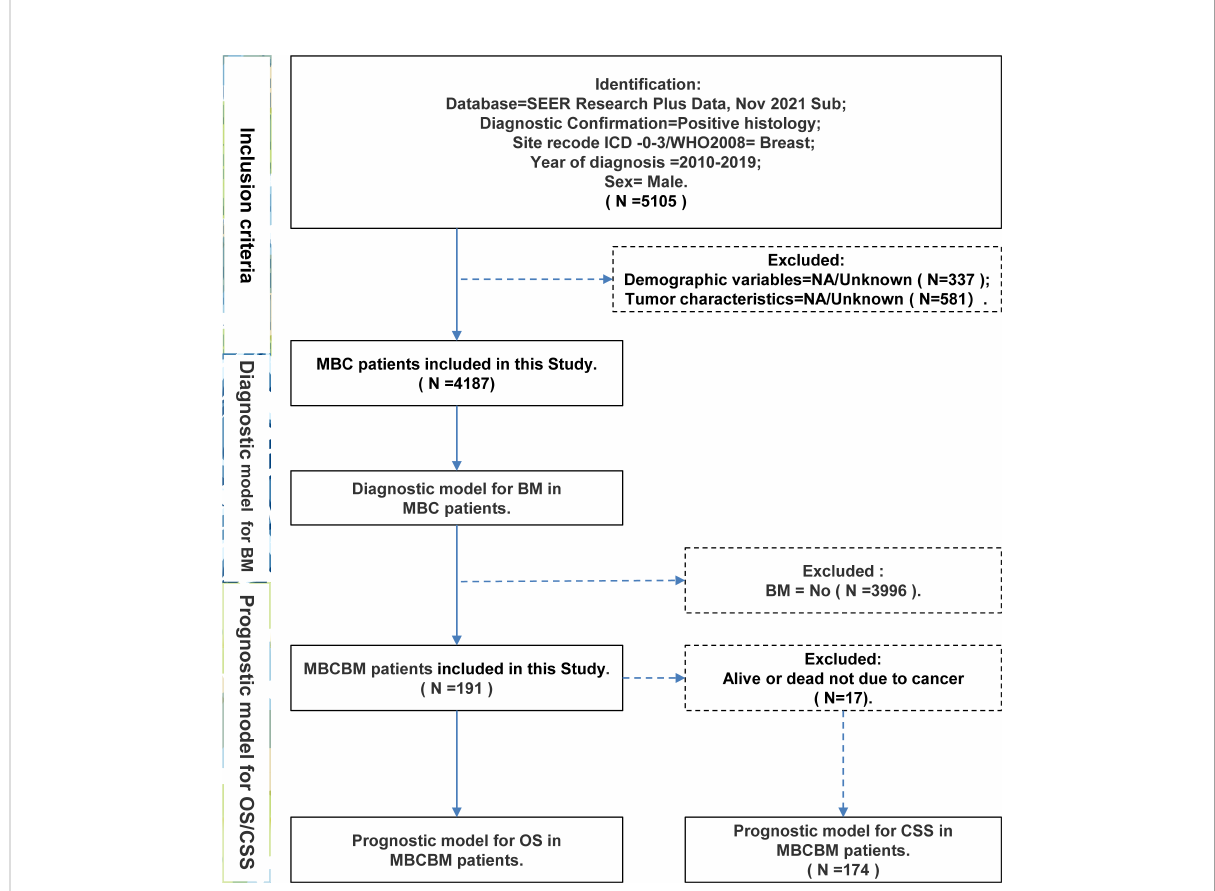
FIGURE 1 The fl ow chart for patient selection and study design (MBC, male breast cancer; BM, bone metastases; MBCBM, Male breast cancer with bone metastases; OS, overall survival; CSS, cancer-speci fi c